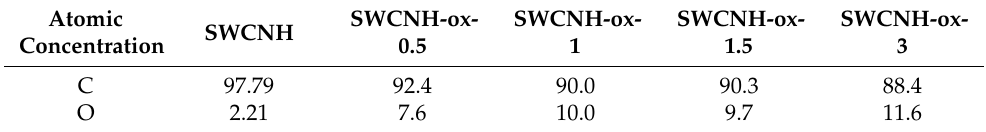
Figure 4. Transmission Electron Microscope (TEM) images of the materials: ( A ) SWCNH, ( B ) SWCNH-ox-0.5, ( C ) SWCNH- ox-1, ( D ) SWCNH-ox-1.5, and ( E ) SWCNH-ox-3. Circles show the tip shapes and an amorphous carbon evaluation through the oxidation process. ( F ) Dependence of I D3 /I G on the oxidation time. Table 1. Atomic concentration of C and O obtained from XPS